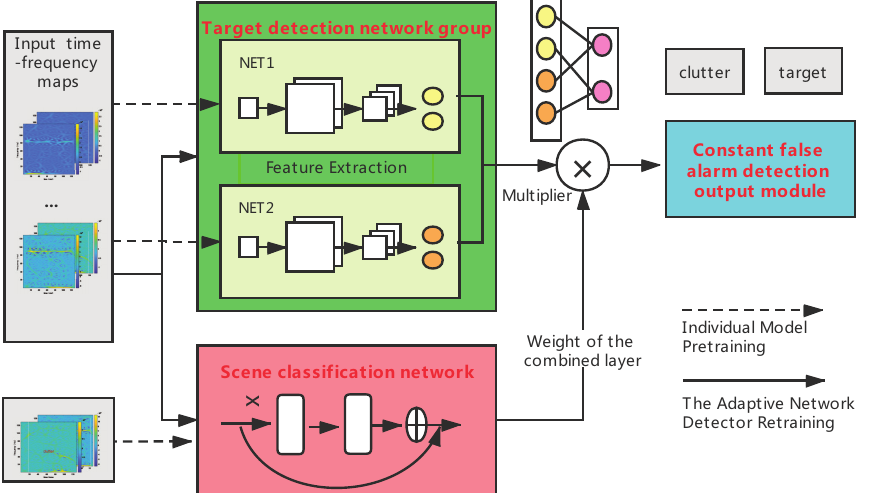
Figure 2. Framework of the adaptive network